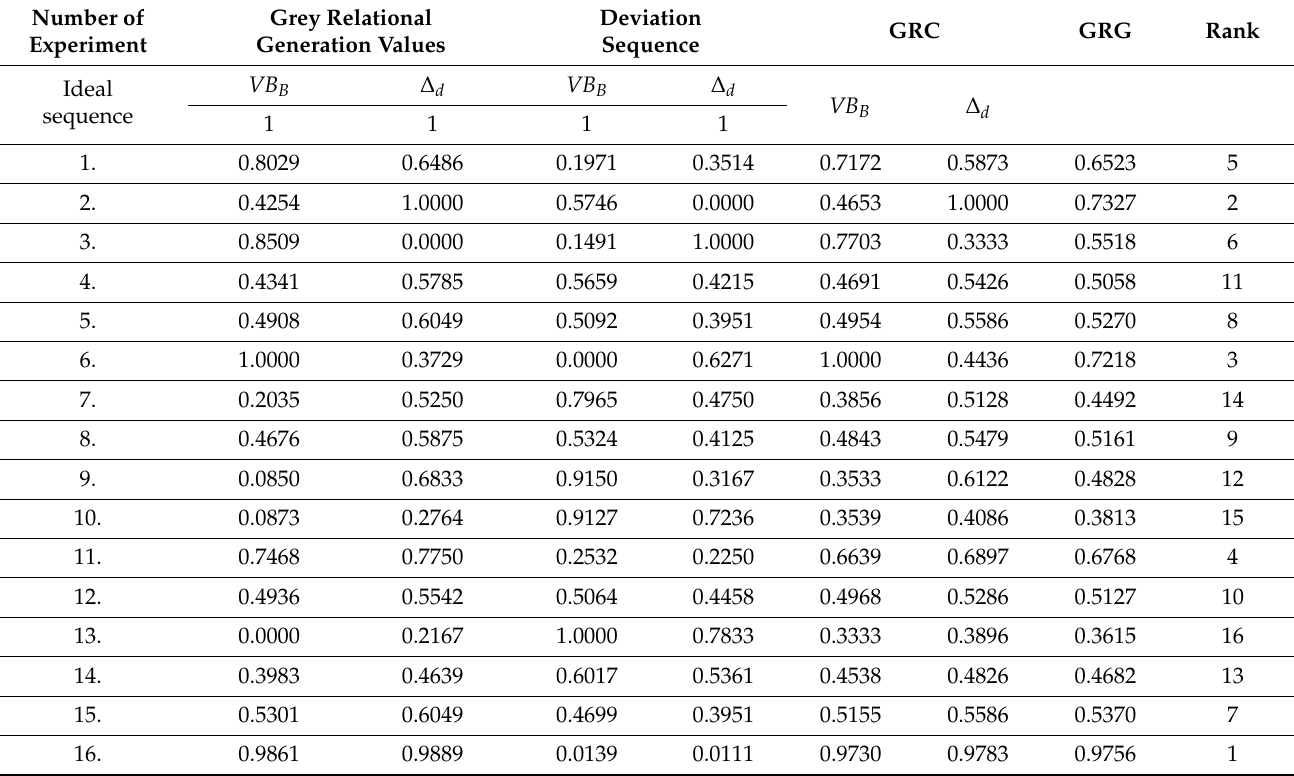
Table 5. Grey relational values.